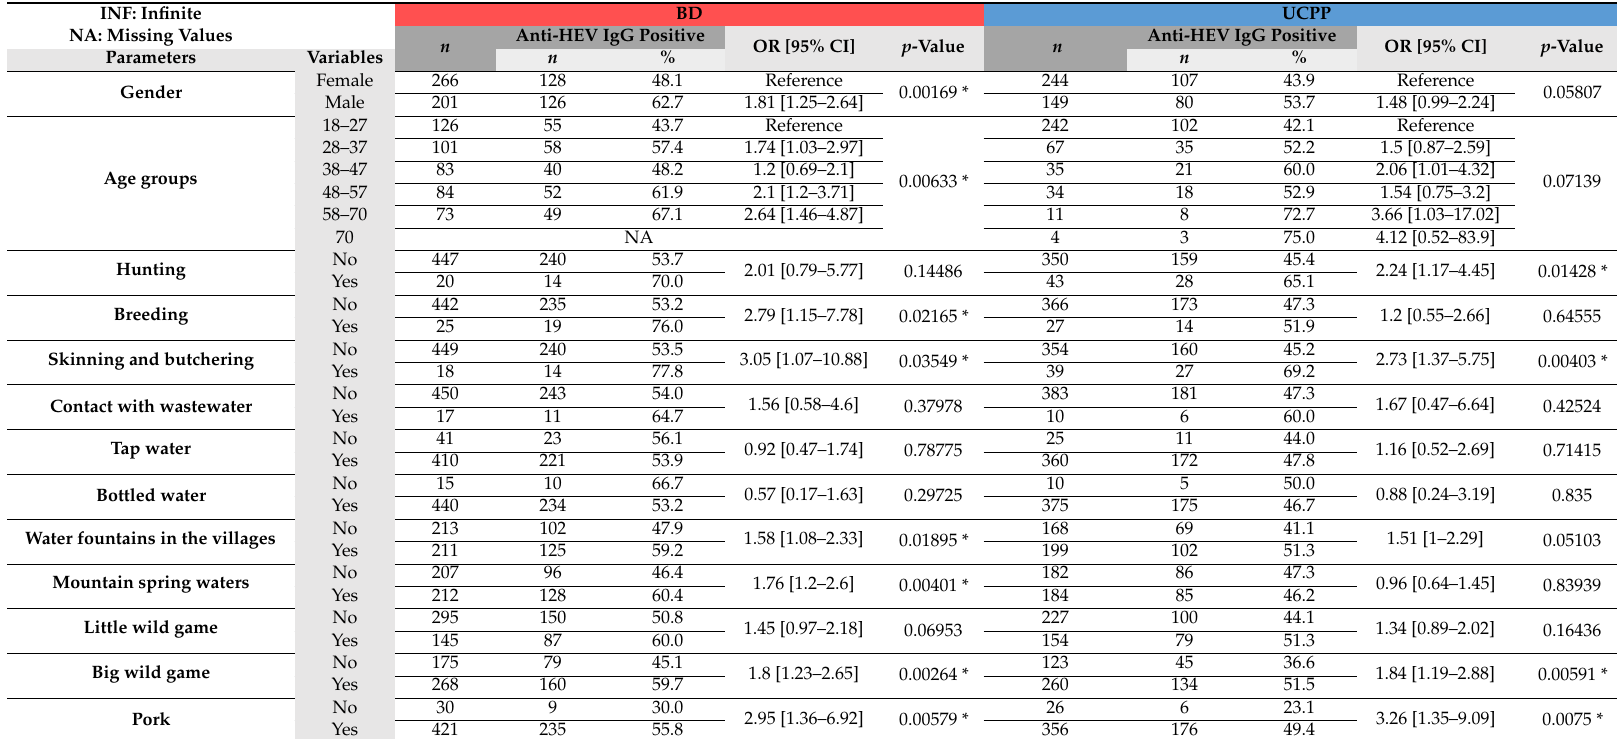
Table 1. Seroprevalence and factors associated with anti-Hepatitis E virus (HEV) IgG detection (univariate analysis). Significant p -values < 0.05 are followed by an